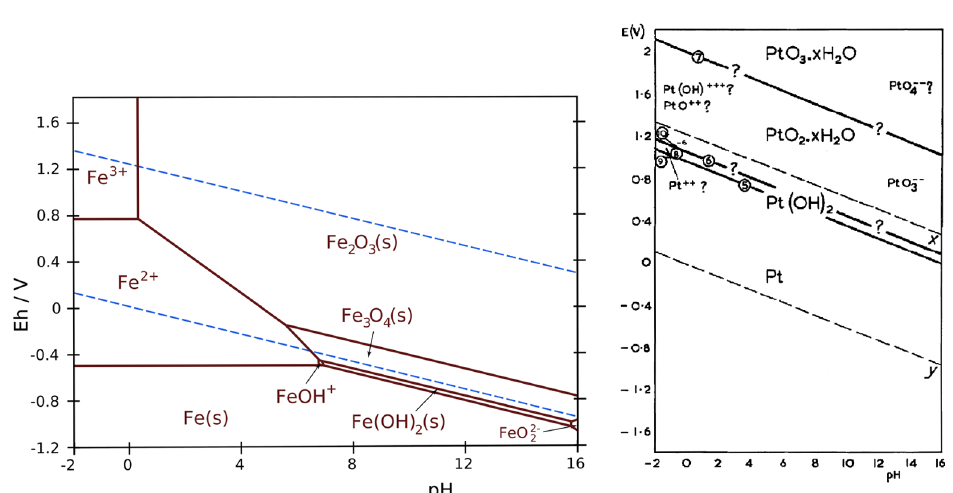
Fig. 18. – Left: Pourbaix diagram from iridium (in HCl), dashed lines denote stability window of water. Right: Pourbaix diagram for platinum. Reproduced from [75] under Creative Com- mons Attribution 4.0 International License. Reproduced from [76] under Creative Commons Attribution-NonCommercial-NoDerivatives 4.0 International License.